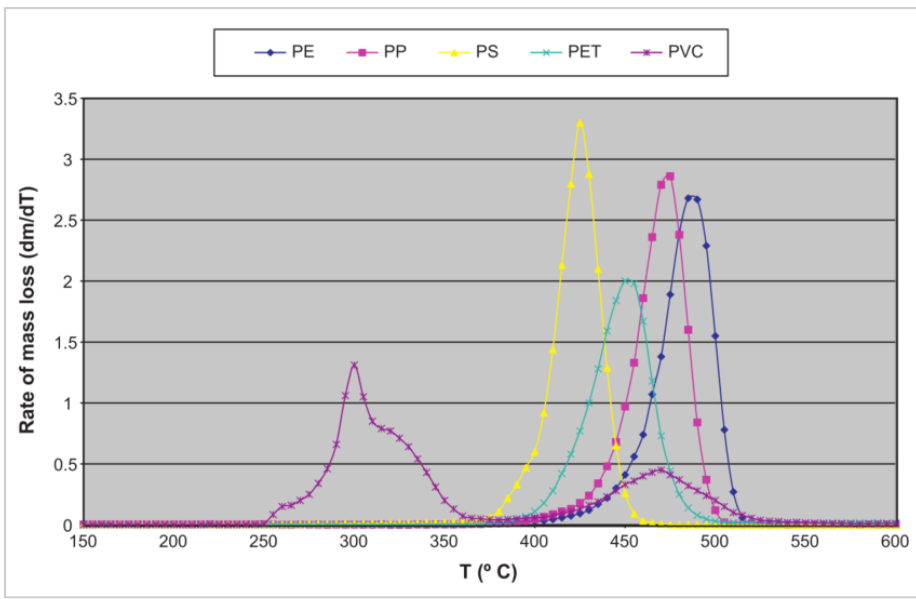
Figure 5. Thermogravimetric analysis (TGA) for determination of degradation temperature for different polymers. Lopez et al. [55].